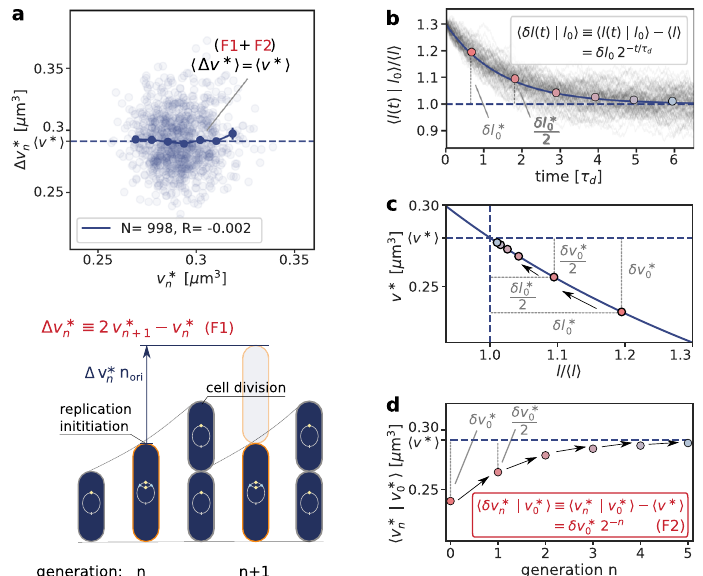
Fig. 4 | Fluctuations in the switch components can give rise to the experi- mentally observed adder correlations in the initiation volume per origin v * , illustrated using the LD model with lipid concentration fl uctuations (Eq.